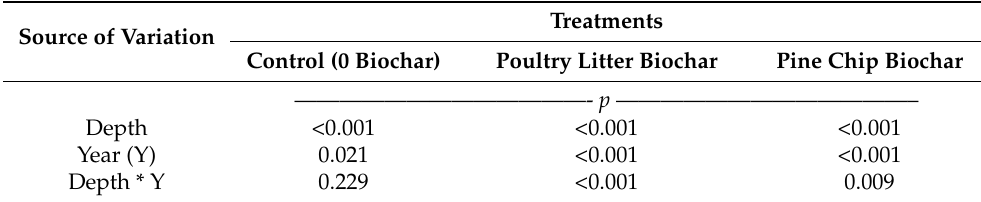
Table 5. Level of statistical significance for each source of variation (i.e., depth, year, and depth * year) for annual mean soil organic carbon content.